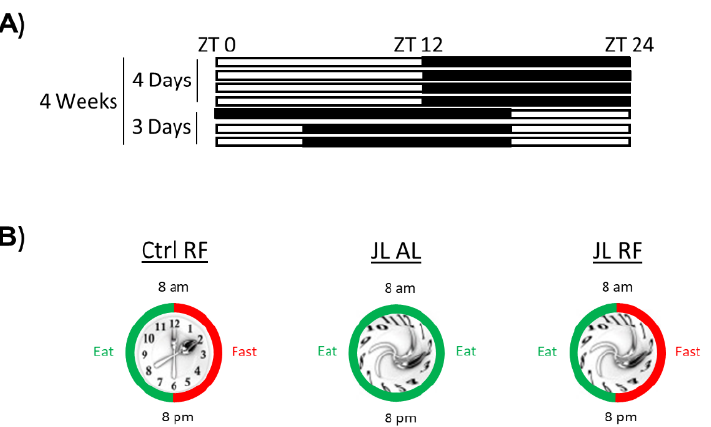
Figure 1. ( A ) Schematic representation of the jetlag model. The light phase is represented in white; the dark phase is represented in black. ZT = Zeitgeber time. ( B ) Graphic representation of control mice fed a TRF diet (Ctrl RF), jetlagged mice fed ad libitum (JL AL), and jetlagged mice fed a TRF diet (JL